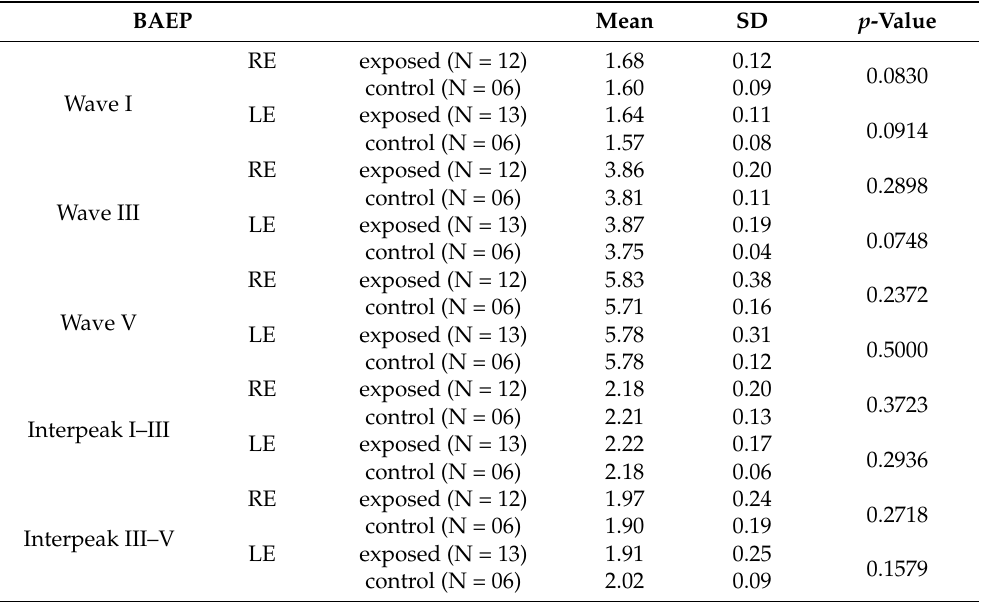
Table 3. Mean and standard deviation of the absolute latencies, interpeak latencies, and amplitudes of waves I’ and V’ obtained in the right and left ears of the exposed and control groups, with auditory thresholds from 30 to 50 dB HL at the frequencies from 2000 to 4000 Hz.